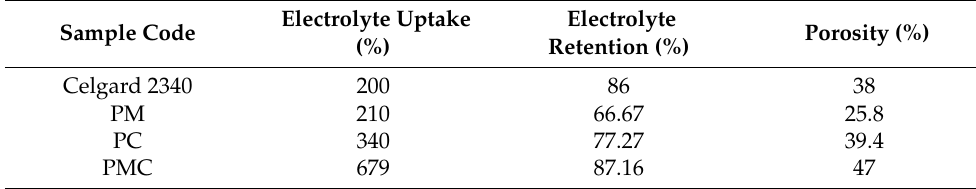
Table 2. Comparison of electrolyte uptake, retention, and porosity of Celgard, PM, PC.